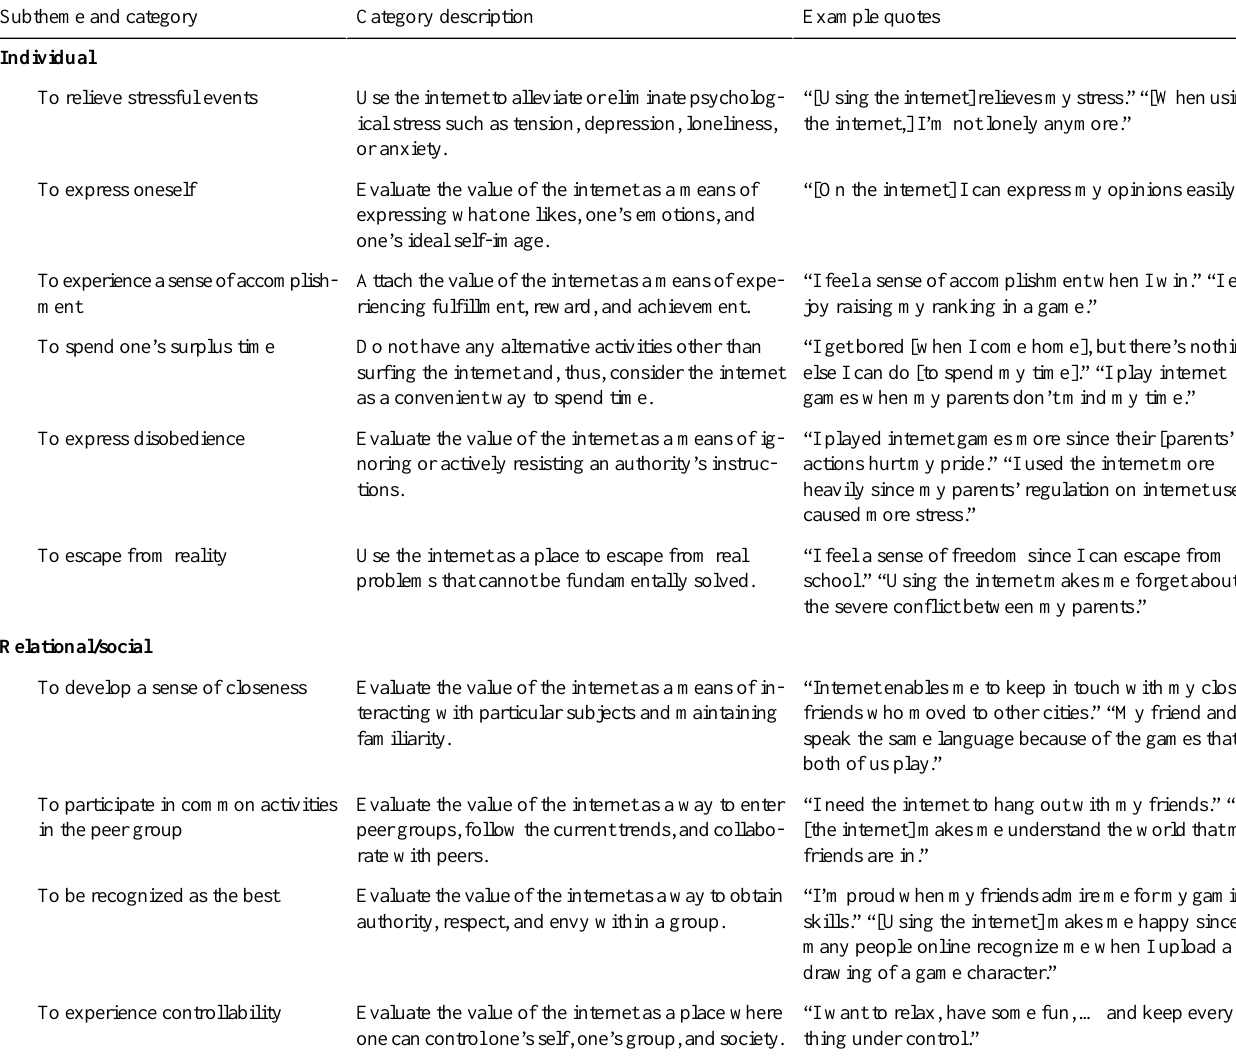
Table 1. Psychosocial value categories of problematic internet use behavior.